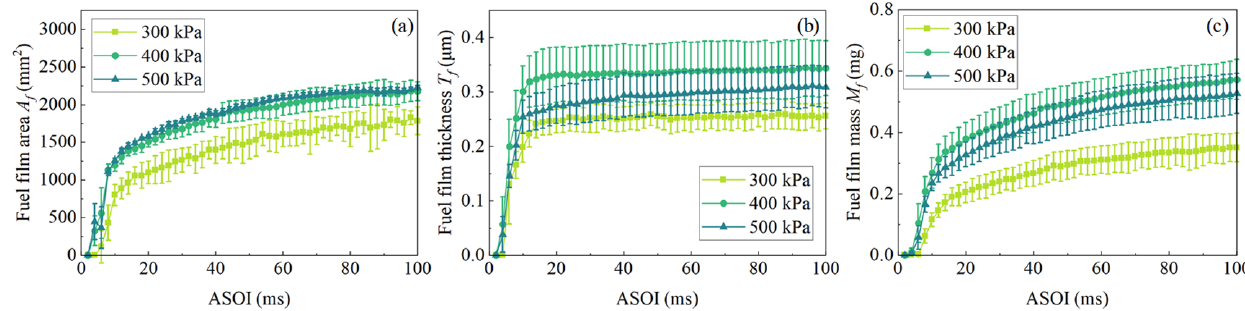
A , ( b ) Fuel film thickness f